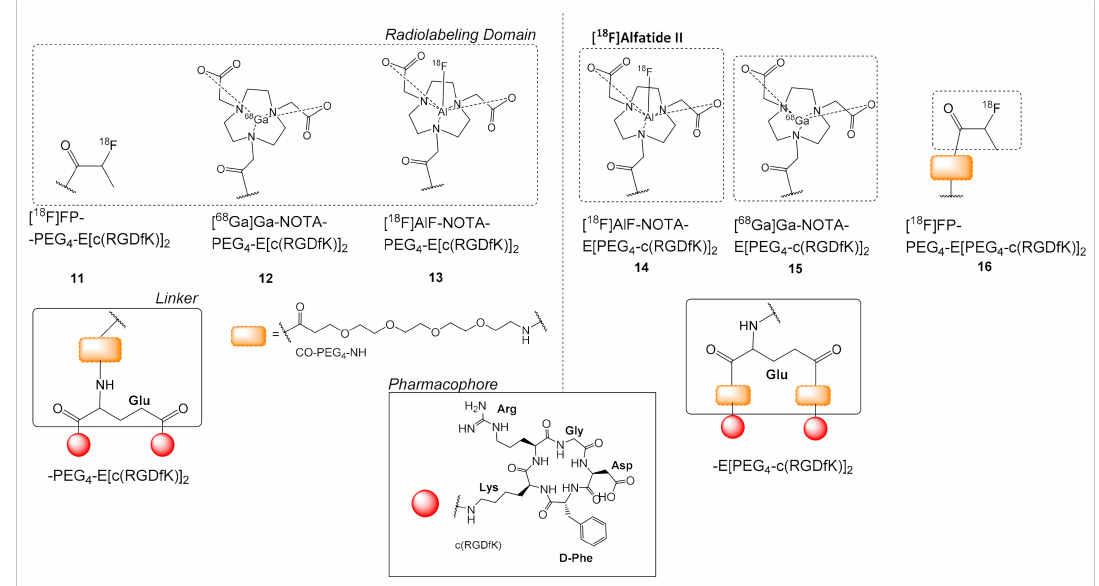
Figure 4. Chemical structures of c(RGDfK)] 2 analogues with PEG 4 spacers; [ 18 F]FP-PEG 4 -E[c(RGDfK)] 2 11 , [ 68 Ga]Ga-NOTA- PEG 4 -E[c(RGDfK)] 2 12 , [ 18 F]AlF-NOTA-PEG 4 -c(RGDfK)] 2 13 , [ 18 F]AlF-NOTA-E[PEG 4 -c(RGDfK)] 2 or [ 18 F]Alfatide II 14 , [ 68 Ga]Ga-NOTA-E[PEG 4 -c(RGDfK)] 2 15 , [ 18 F]FP-PEG 4 -E[PEG 4 -c(RGDfK)] 2 , 16 (HN-PEG 4 -COOH = 15-amino-4,7,10,13- tetraoxapentadecanoic